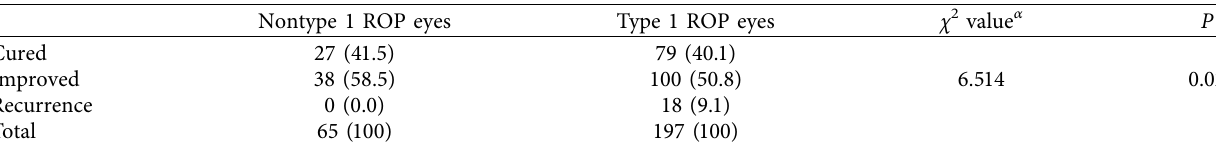
Table 2: Comparison of efects for the eyes with type 1 and nontype 1 ROP after intravitreal injection of anti-VEGF drugs ( N � 262).